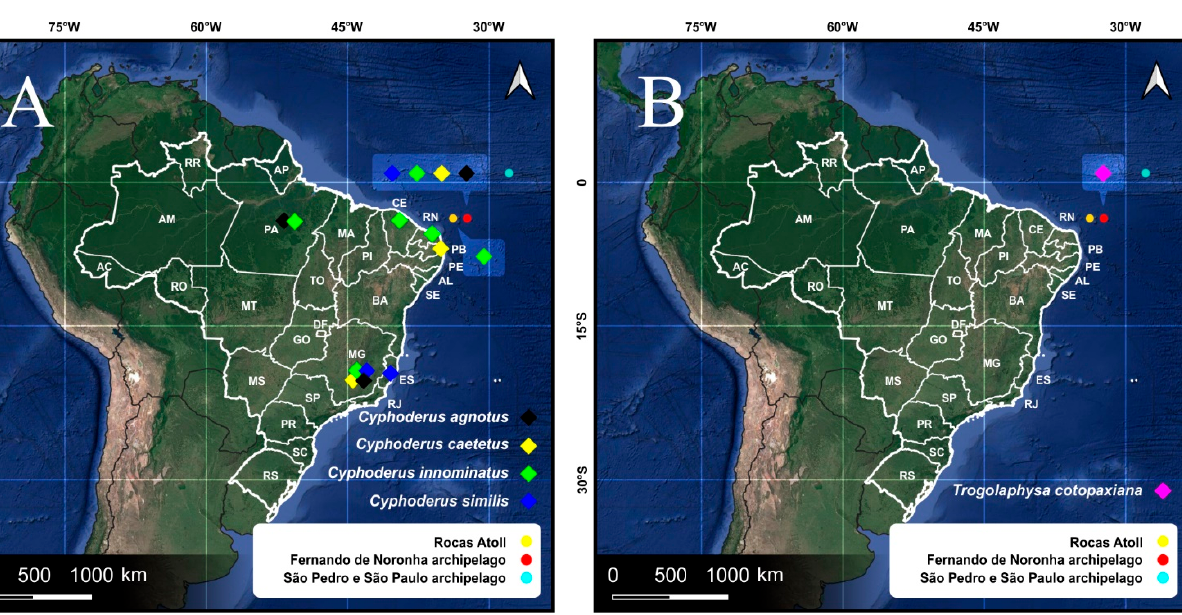
Figure 15. Distribution map for Paronellidae records in Brazil mainland and oceanic islands. ( A ). Cyphoderus agnotus, C. caetetus, C. innominatus and C. similis ; ( B ), Trogolaphysa cotopaxiana.